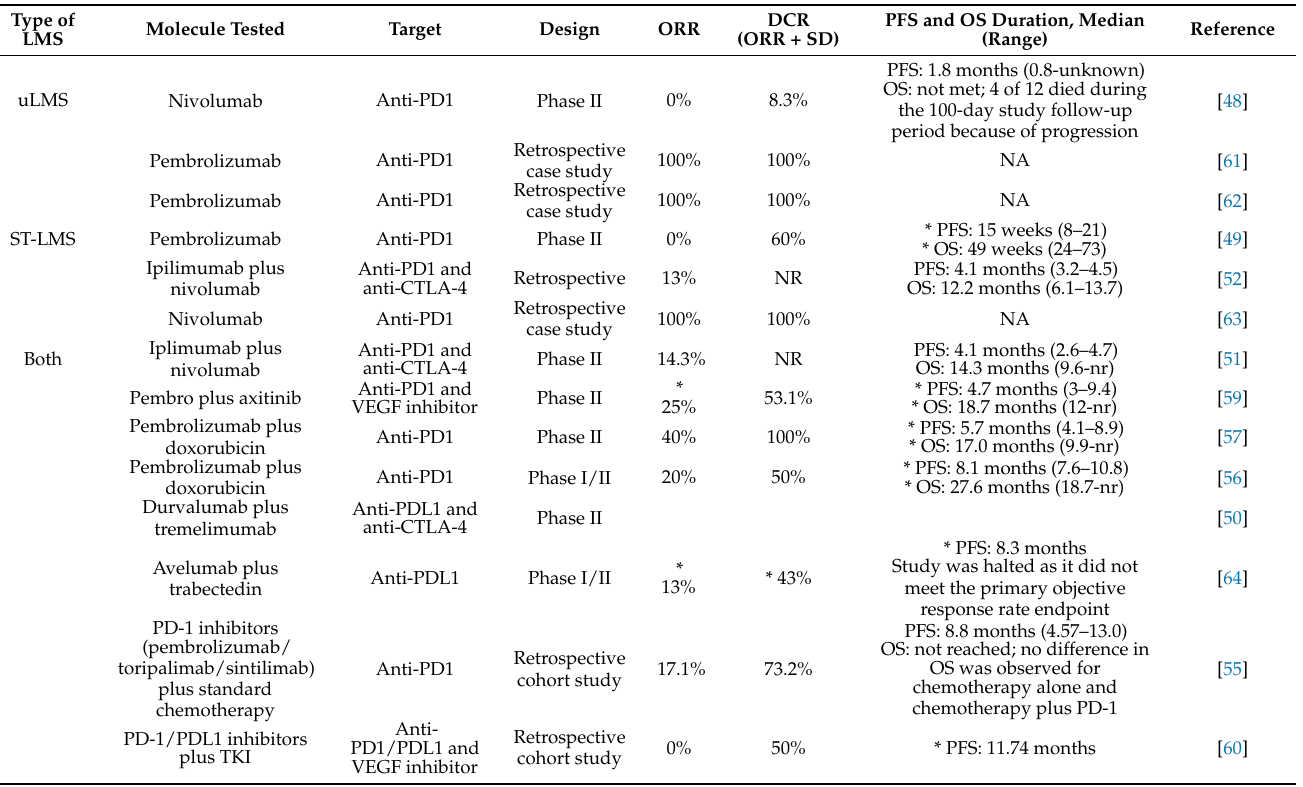
Table 1. Use of immunotherapy checkpoint blockade in the treatment of leiomyosarcoma.